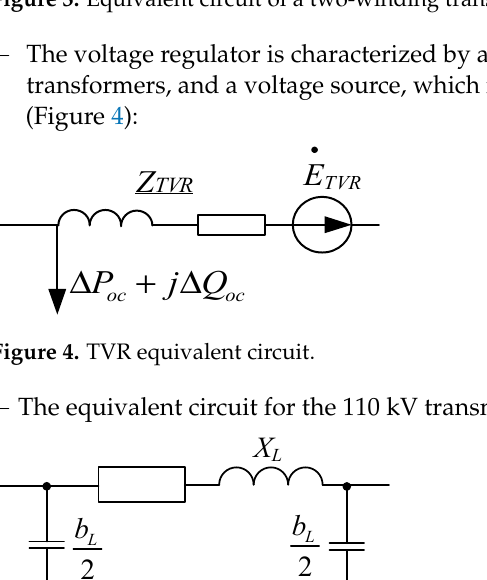
Figure 5. Equivalent circuit of 110 kV transmission line.